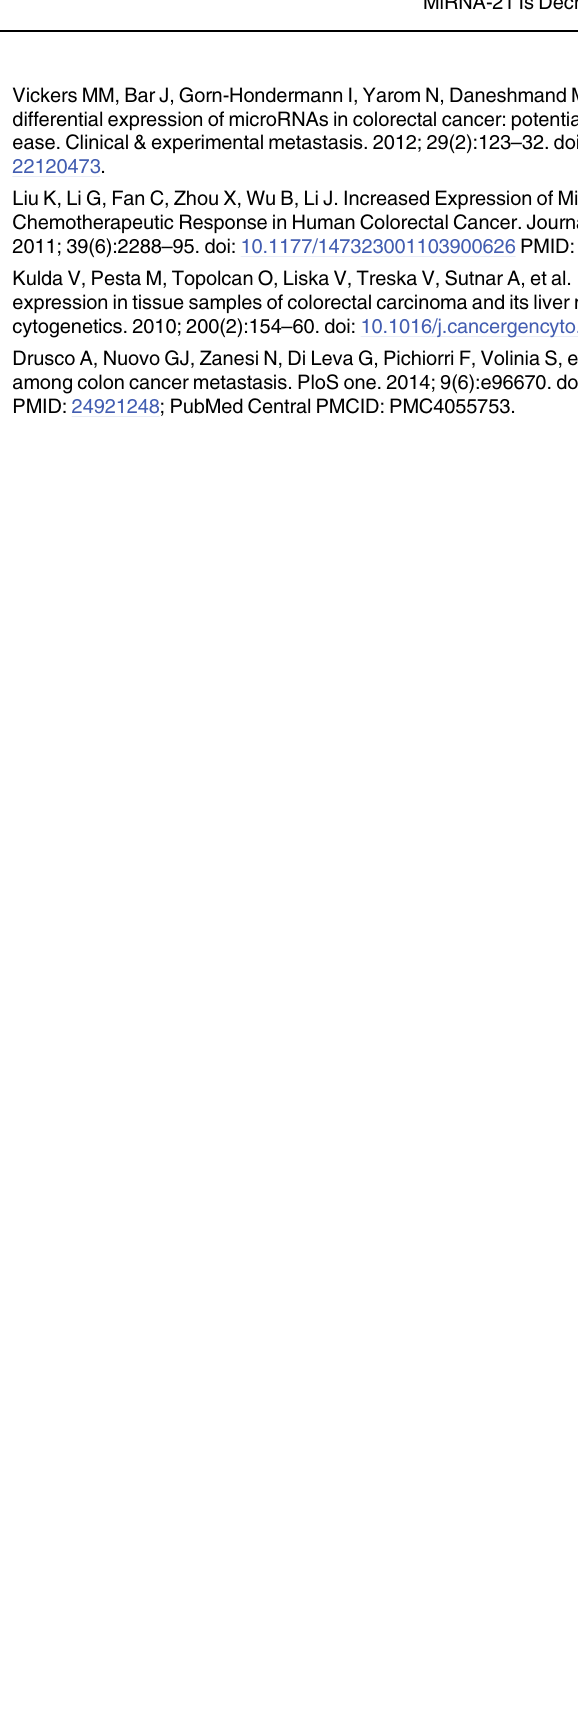
PLOS ONE | DOI:10.1371/journal.pone.0148580 February 4,